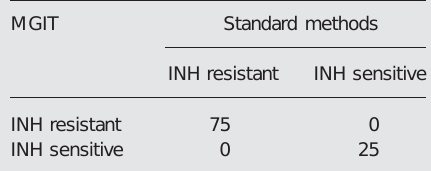
Table 2 - Comparison of results of the mycobacte- ria growth indicator tube (MGIT) versus standard methods for isoniazid (INH).